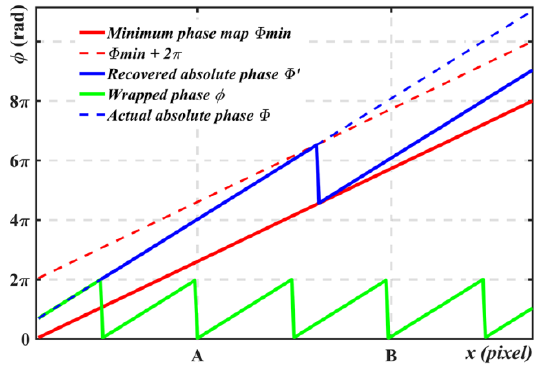
Figure 4. Phase unwrapping using the minimum phase map Ф min .